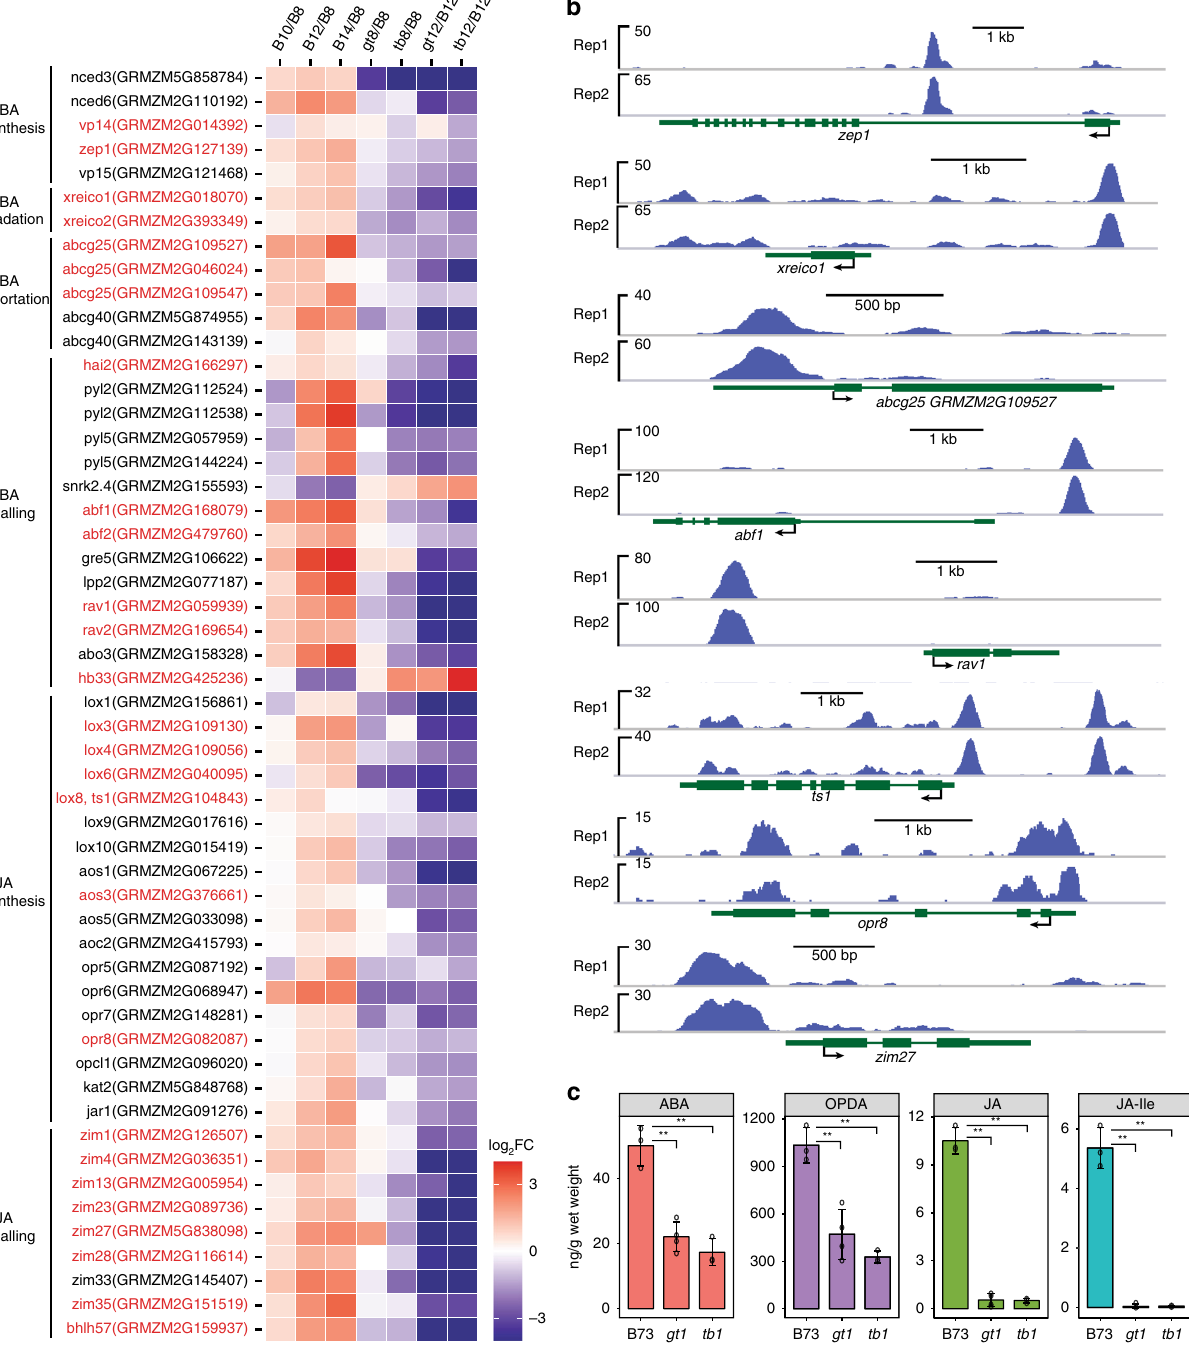
Fig. 3 Bud dormancy is associated with tb1 - gt1- mediated regulation of ABA and JA hormone homeostasis and signaling. a Genes involved in ABA biosynthesis, ABA degradation, ABA transportation, ABA signaling, JA biosynthesis and JA signaling were up-regulated in tiller buds across the B73 developmental series (B10/B8, B12/B8, B14/B8), but down-regulated in growing gt1 and tb1 buds. Stages and genotypes are indicated as described in Fig. 1, with slashes representing pairwise comparison between two samples (e.g. B10/B8 is a pairwise comparison between B73 buds at 10 vs. 8 DAP). Genes were highlighted in red if they were also putative direct targets of TB1 identi fi ed by ChIP-seq. FC fold change. Gradient color scale indicates the log value of expression fold change (log 2 FC). b TB1 ChIP-Seq-binding peaks near differentially expressed ABA and JA genes from (A). rep1 and rep2 represent two biological replicates of the TB1 ChIP-seq assay. c Quanti fi cation of ABA, OPDA, JA, and JA-Ile levels in tiller buds of B73, gt1 , and tb1 at 12 DAP. OPDA 12-oxo-phytodienoic acid, JA-Ile Jasmonic acid-isoleucine. Data are means± SE calculated from at least three biological replicates. ** p < 0.01; two-tailed Student ’ s t-